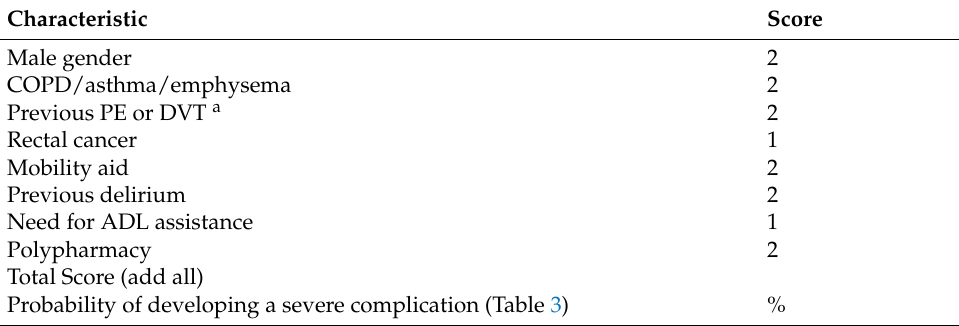
Table 3. Geriatric colorectal cancer model (GerCRC) score